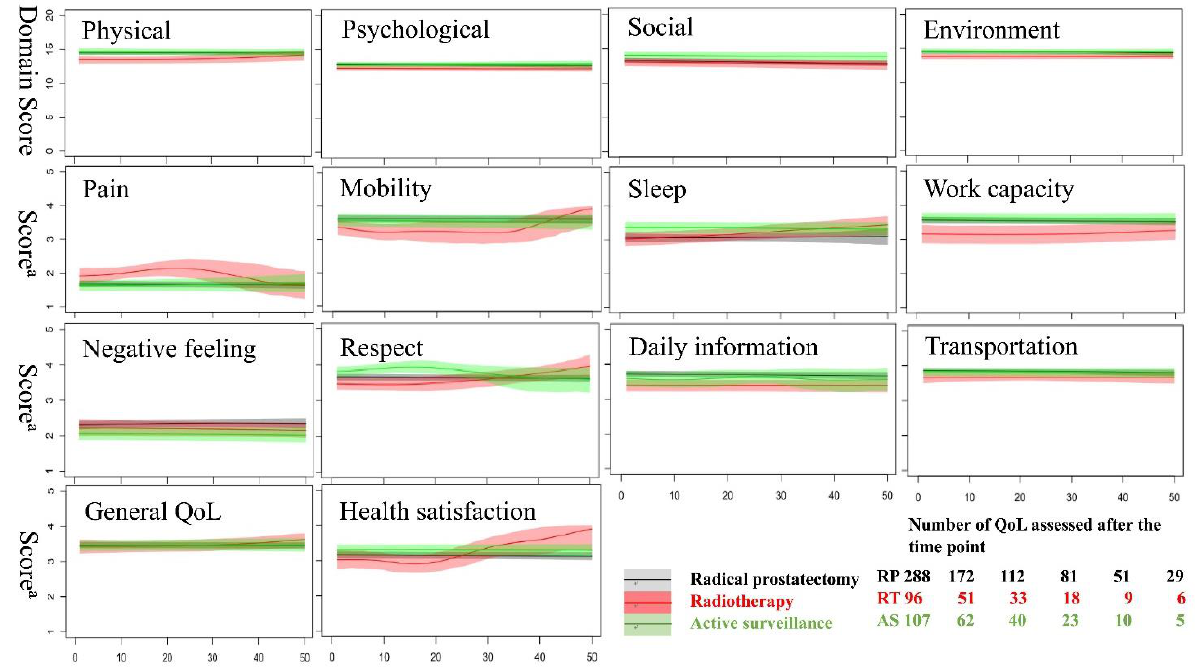
Figure 1. Dynamic changes in the World Health Organization Quality of Life-BREF (WHOQOL-BREF) scores for general quality of life, health satisfaction, four domains, and eight facets, with significant QoL differences among three standard localized prostate cancer treatments. A 95% confidence interval is illustrated as a colored shadow for each specific item score. a Score of facets in the WHOQOL-BREF. Patients under observation were also included in the active surveillance group. AS, active surveillance; RP, radical prostatectomy; RT, radiotherapy; QoL, quality of life; WHOQOL-BREF, short form of World Health Organization Quality of Life Questionnaire.